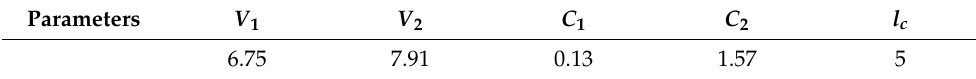
Table 1. Parameters value in Equation (3) [35].